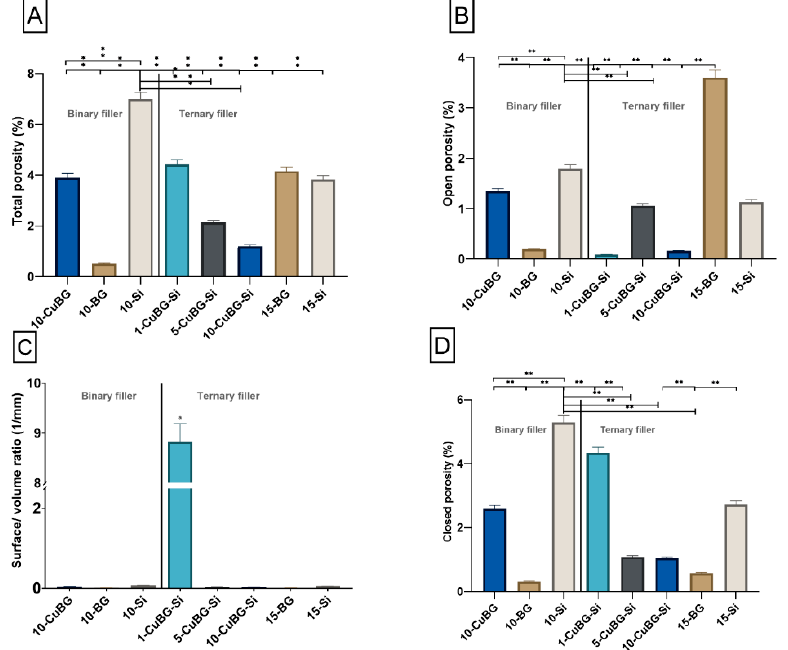
Figure 7. Graphical illustration of qualitative analysis of porosity of materials in the Binary filler and Ternary filler groups. ( A ) Total porosity of experimental composites, ( B ) percentage of open porosity in experimental composites, ( C ) surface and volume ratio of composite and ( D ) percentage of closed porosity in experimental composites. ( A – D ) were analyzed and calculated by using nano-CT and Amira-Avizo 3D Software ver 2022.1. Three samples from each group (n = 3) were used for analysis. Data presented as mean values with standard deviations. An asterisk indicates statistically significant differences (* p < 0.05,** p < 0.01).